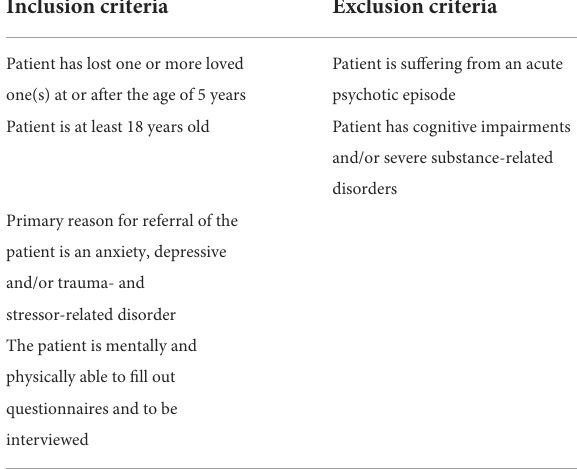
TABLE 2 Inclusion and exclusion